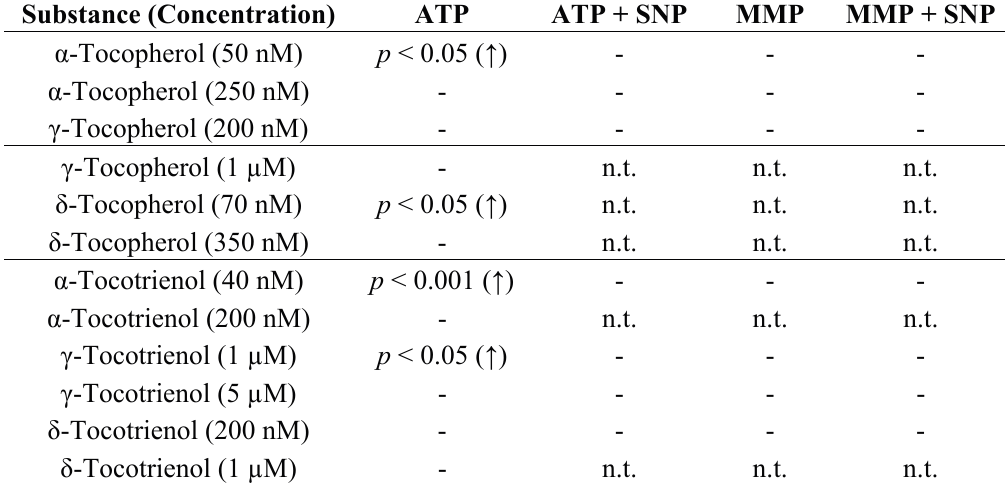
Table 2. Basal ATP concentrations and mitochondrial membrane potential (MMP) of PC12 cells after 24-h incubation with the indicated pure substances contained in rice bran extract (RBE) and MMP and ATP after preincubation with pure substances for 1 h and subsequent insult with SNP (0.5 mM) for 6 h (ATP) or 24 h (MMP); the solvent control ethanol did not